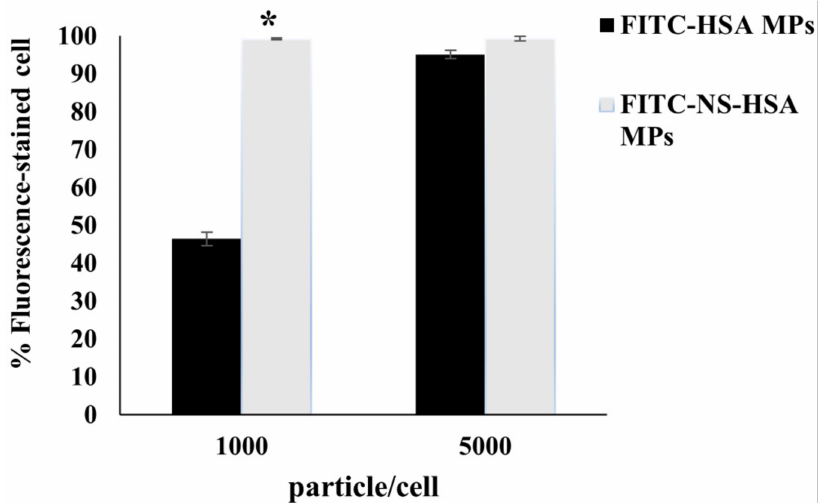
Figure 7. Percentage of cellular uptake of FITC- NS-HSA MPs and FITC- NS-HSA MPs by A549 cells analyzed by the presence of fluorescence intensity by FACS. Data are presented as mean ± SD. * p ≤ 0.05 was determined by t -test.